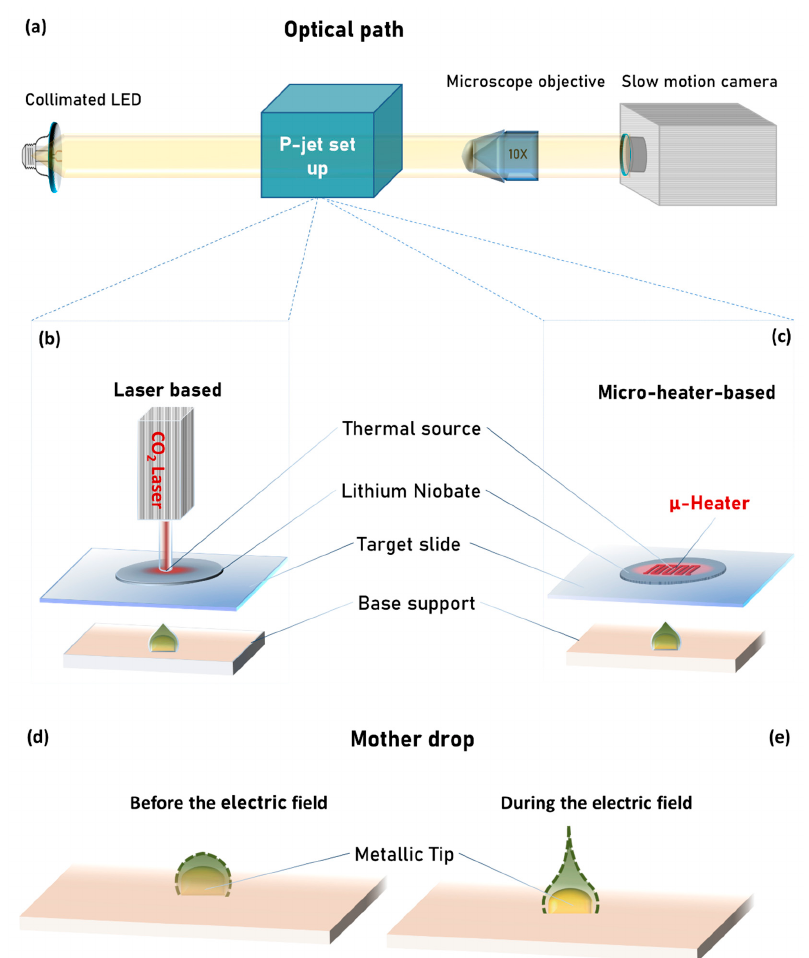
Figure 1. Schematic view of: ( a ) pyro-electrohydrodynamic jet (p-jet) set-up optical path; ( b ) p-jet system in laser-based configuration; ( c ) p-jet system in micro-heater-based configuration; shape of the mother drop ( d ) before and ( e ) during the electric field application.